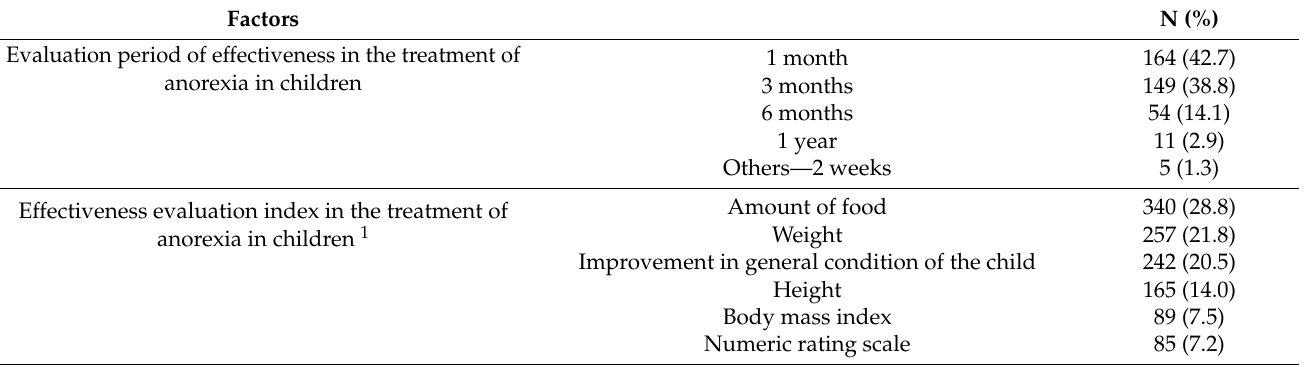
Table 6. Safety and effectiveness of Korean medicine treatments in children with anorexia (N =